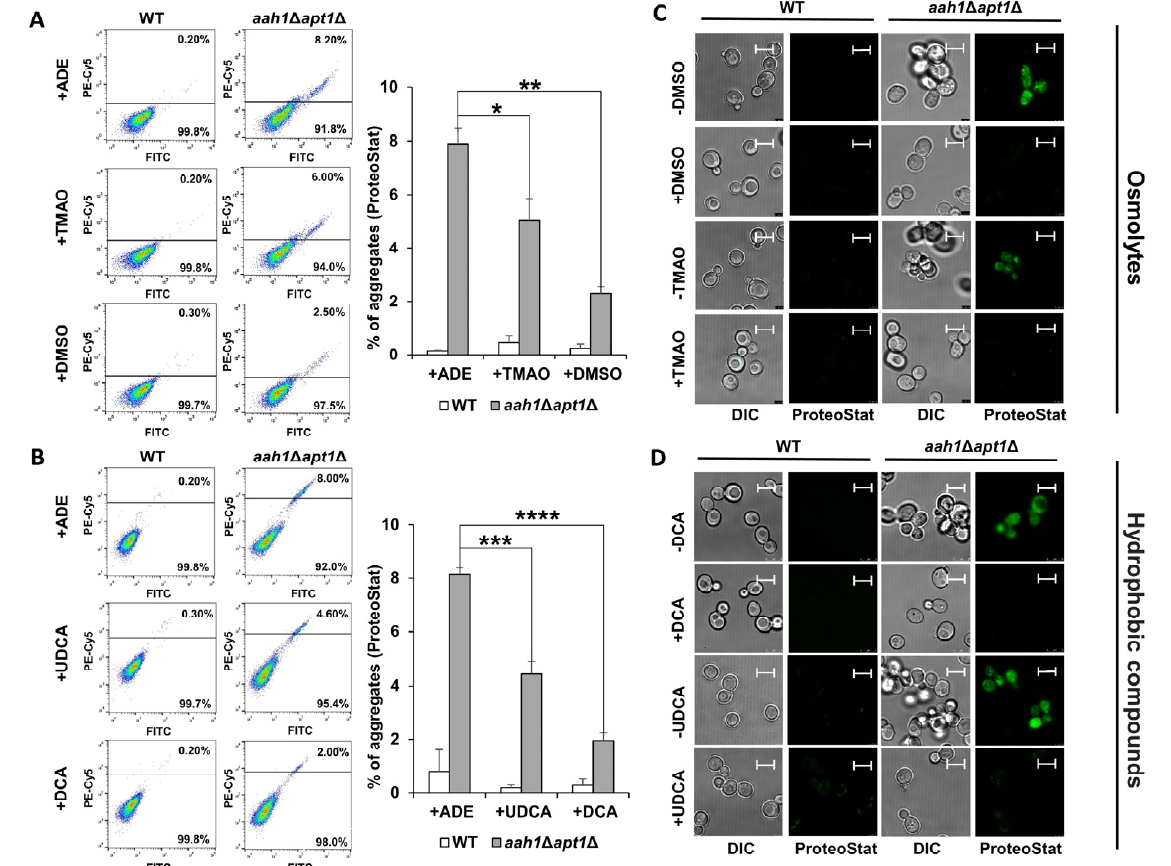
Figure 3. Chemical chaperones inhibit adenine aggregation in the salvage yeast model. ( A , B ) Flow cytometry analysis of wild type (WT) and aah1 Δ apt1 Δ yeast cells under the indicated conditions following ProteoStat staining. Left: Flow cytometry data. Right: Quantification of ProteoStat positive cells under the indicated conditions. * p < 0.05; ** p < 0.005; *** p < 0.001; **** p < 0.0001 (Student’s t -test). Values are the average ± s.d. of three independent biological repeats. ( A ) 2 mg/L adenine (+ADE), 2 mg/L adenine and 1 mM TMAO (+TMAO) or 140 mM DMSO (+DMSO). ( B ) 2 mg/L adenine containing 0.05% DMSO (+ADE), 2 mg/L adenine containing 0.05% DMSO, 10 µ M UDCA (+UDCA) or 10 µ M DCA (+DCA). ( C , D ) Representative confocal microscopy images of WT and aah1 ∆ apt1 ∆ cells under the same conditions as in ( A , B ). Scale bar is 5 µm.